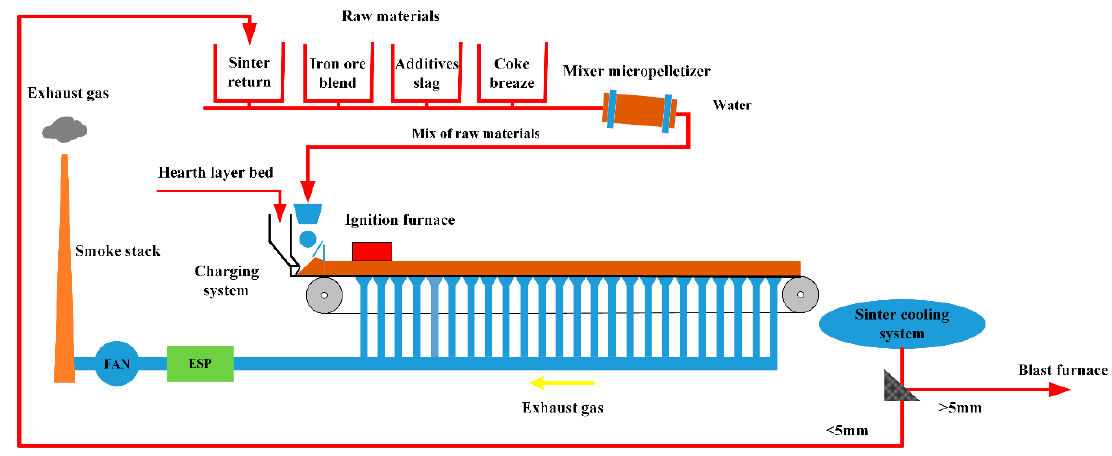
Figure 1. Iron ore sintering process.